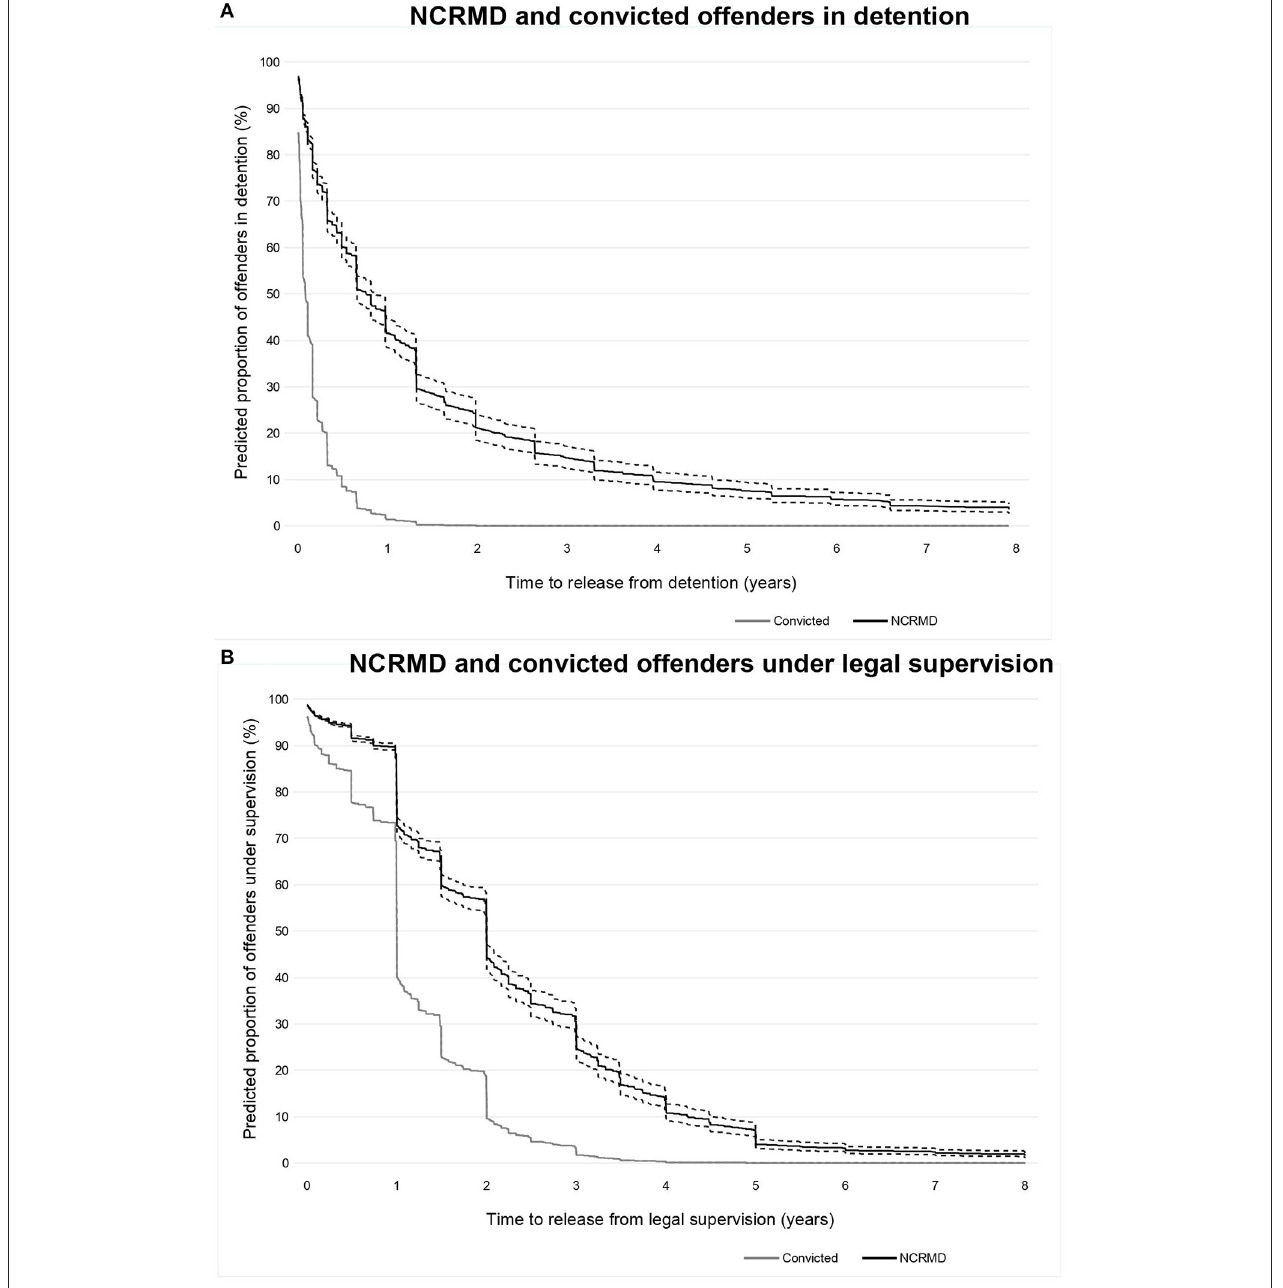
FIGURE 2 | (A,B) Predicted proportion of NCRMD and convicted offenders in detention and under legal supervision over the years following a verdict a . – Represent confidence